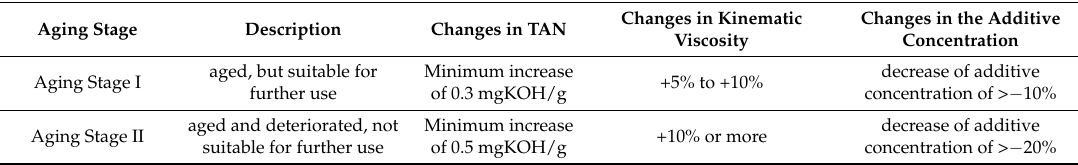
Table 2. Parameters defining the condition of aged oils.